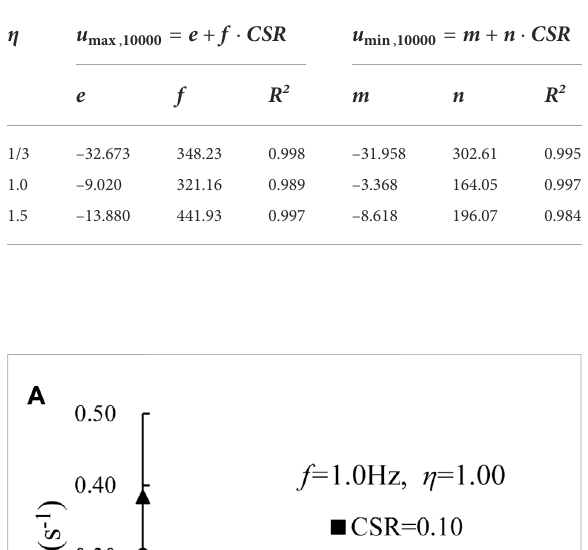
TABLE 3 Fitting parameters under different conditions.